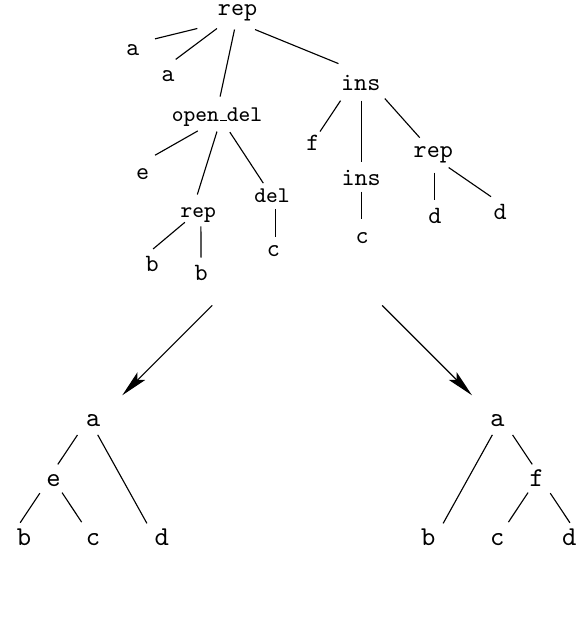
Figure 11. Graphical view of tree alignment with oscillating gaps. Core operators mty and ∼ are not shown. Note that after the gap opening for the deletion of e , oscillation allows for a gap extension when inserting f . In this core term, the top rep node and the open del are derived from nonterminal symbol N , the two ins nodes from S , and the others from P